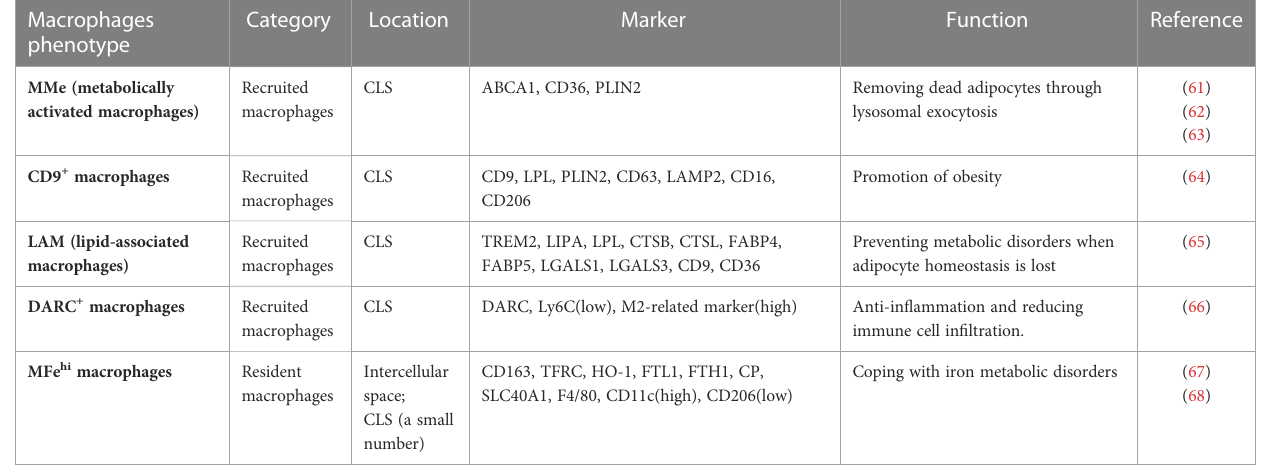
TABLE 1 Newly identi fi ed adipose tissue subtypes.